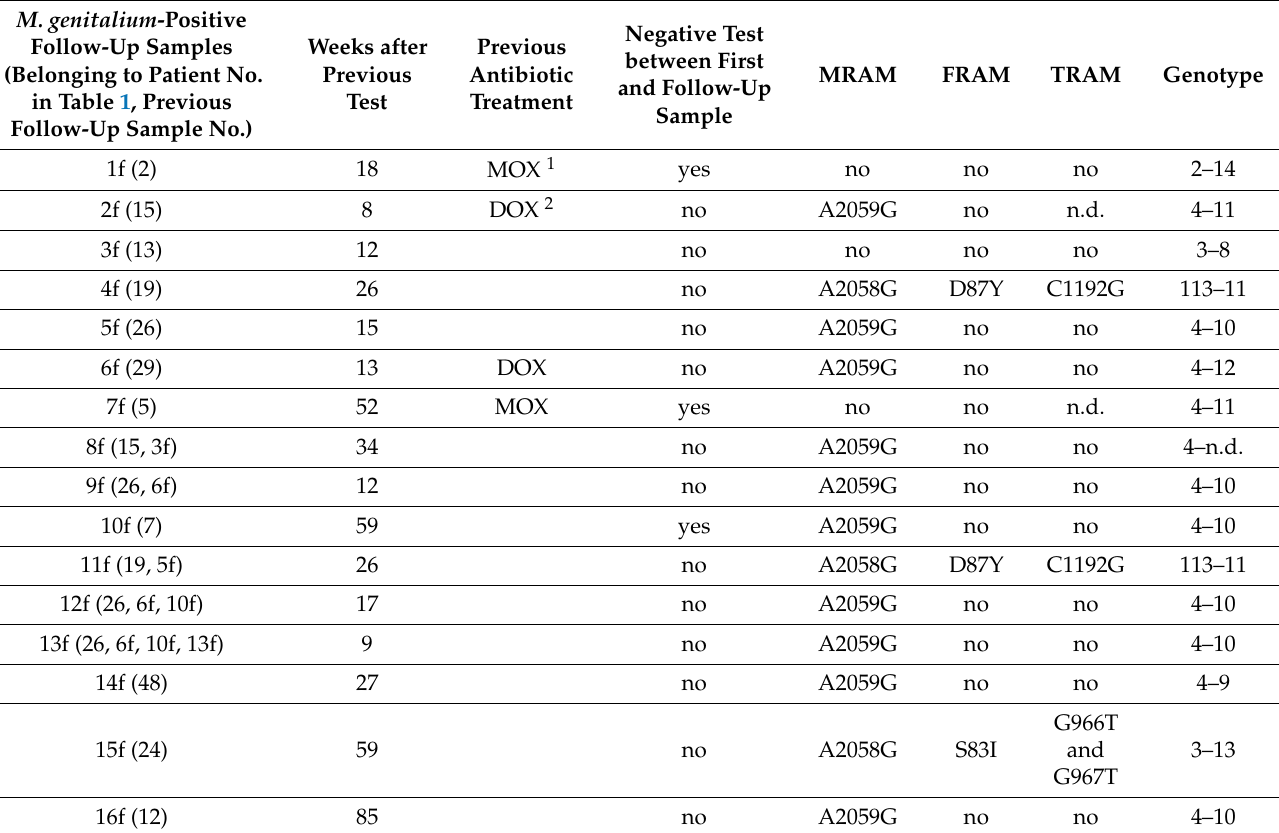
Table 3. Characteristics of M. genitalium strains in follow-up